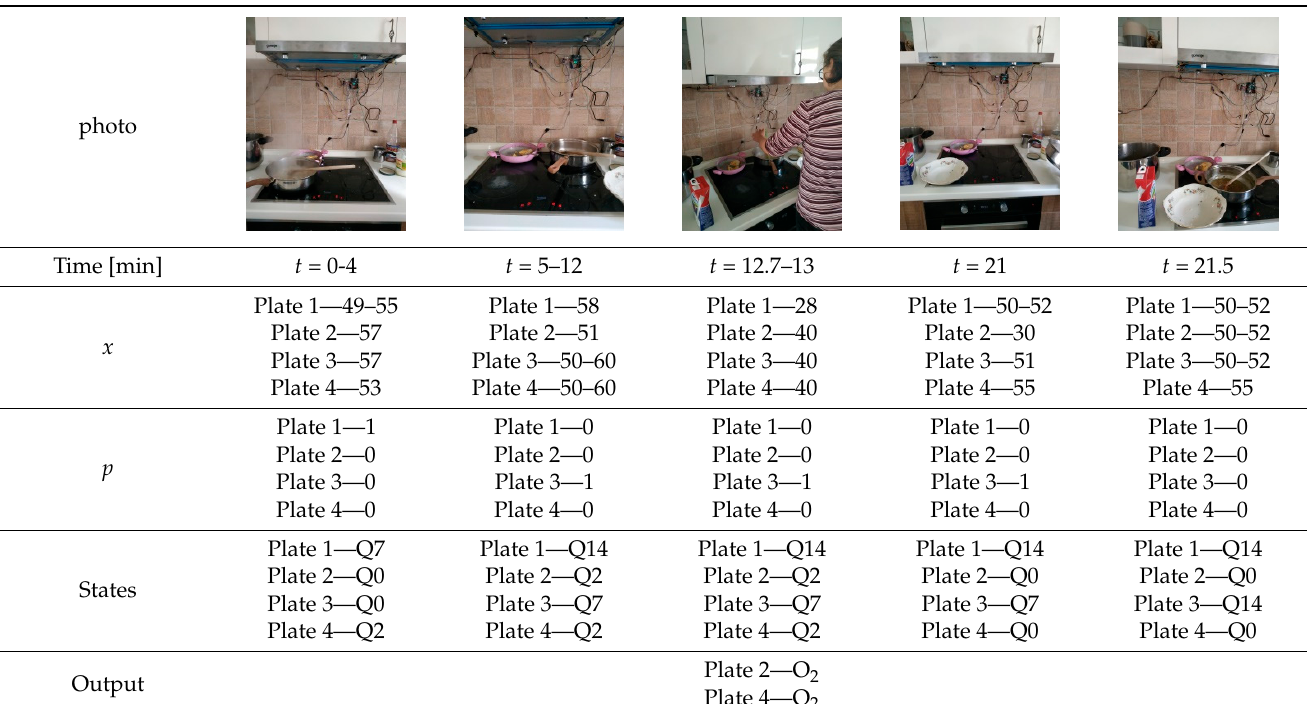
Figure 9. Measured distances for each plate during the typical cooking process. Table 8. Analysis of the results for typical cooking process.